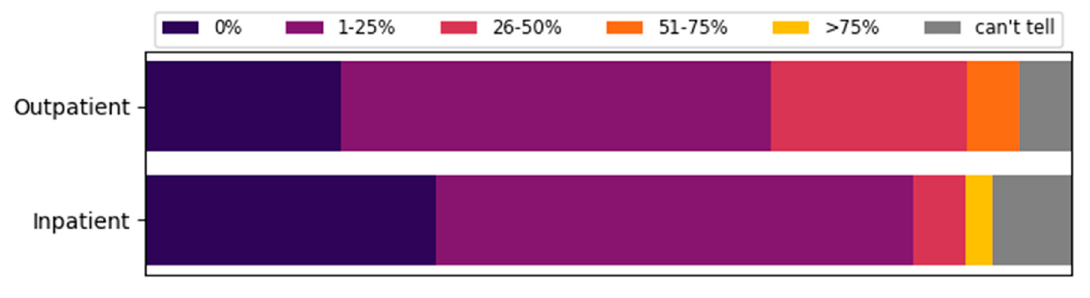
Figure 2. Fractions of cancelled outpatient appointments and inpatient admissions of NET patients due to the COVID-19 pandemic as estimated by NET professionals. Outpatient cancellations: 0% ( n = 15 / 22%), 1–25% ( n = 33 / 49%), 26–50% ( n = 15 / 22%), 51–75% ( n = 4 / 6%), > 75% ( n = 0). Inpatient cancellations: 0% ( n = 22 / 34%), 1–25% ( n = 36 / 56%), 26–50% ( n = 4 / 6%), 51–75% ( n = 0), > 75% ( n = 2 / 3%). Patients with NET require a wide range of laboratory, endoscopic and radiological / nuclear medical (CT / MRI 37%, n = 26), endoscopic workups (30%, n = 21) and with FDG / Ga68-PET / CT (34%, n = 24), with more extensive delays in the university sector (46% vs. 25%, 36% vs. 22% and 38% vs. 28%, see question C6, Figure 3). Minor delays occurred in laboratory medicine and PRRT. In 19 participants (27%), it was stated that there were no delays in